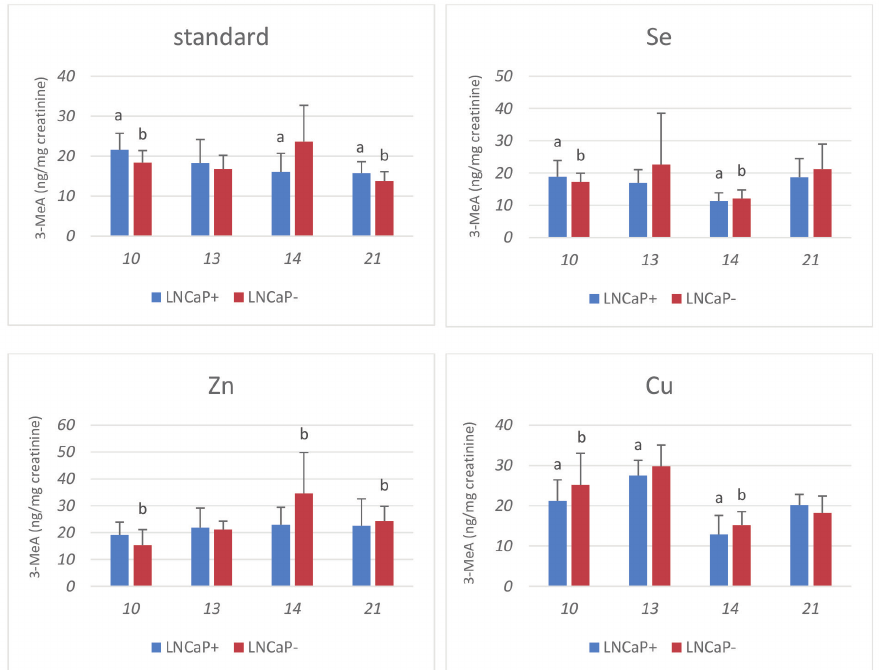
Figure 3: The effect of Se, Zn and Cu supplementation on the excretion of urinary 3-methyladenine (ng/mg creatinine) (10-13-14-21 week) in rats treated and non-treated with prostate cancer cells. a – groups implanted cancer cells; group fed standard diet versus groups fed diet with addition of trace elements (p≤0.05). b – groups non-implanted cancer cells; group fed standard diet versus groups fed diet with addition of trace elements (p≤0.05). * - implanted versus non-implanted cancer cells